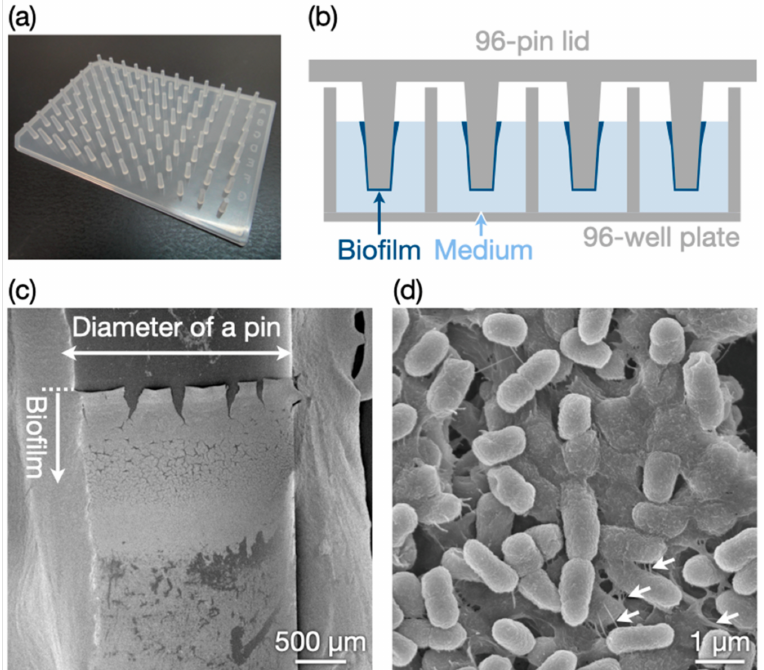
Figure 1. Preparation of an in vitro biofilm model. ( a ) Photograph of the 96-pin lid. ( b ) Schematic illustration of biofilm preparation. SEM images of prepared biofilms at ( c ) low and ( d ) high magnifi- cations. The dotted line in ( c ) indicates the upper edge of the biofilms. The arrows in ( d ) indicate nanofibrous